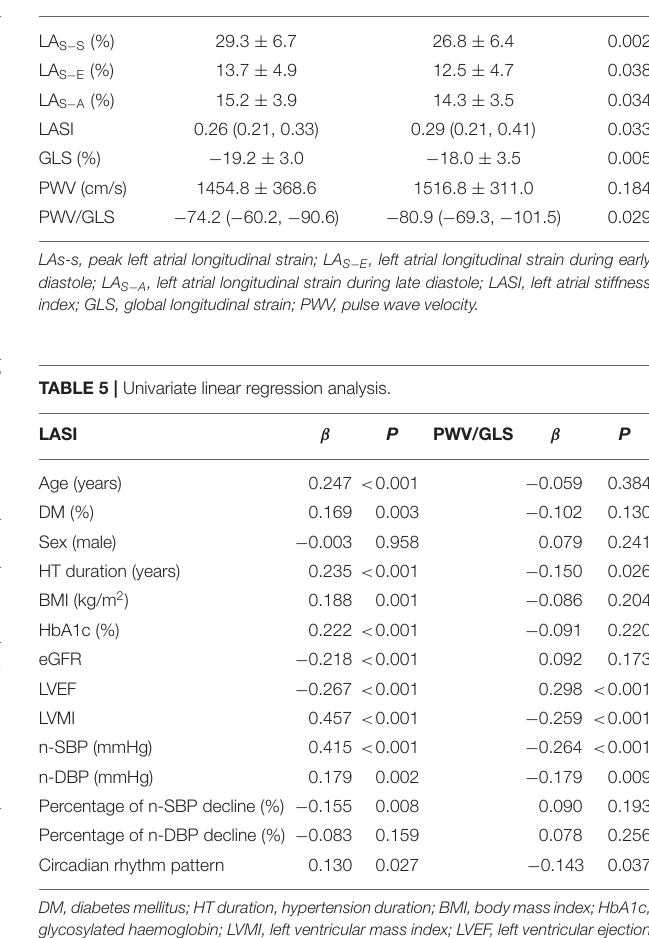
TABLE 4 | Cardiac strains and LA-LV-arterial coupling parameters. Dippers, Non-dippers,